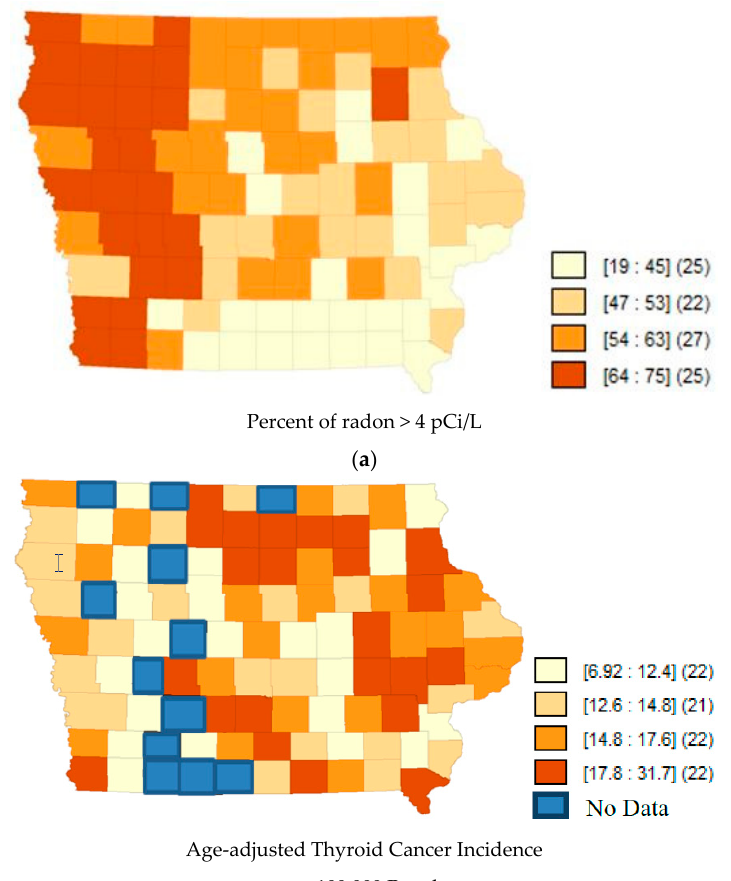
Figure 1. ( a ) Map of Quartiles of Radon Concentrations in Iowa counties. Darker shades represent a higher percent of radon above 4pCi/L. The numbers inside the brackets represent the range of percentages in that shade. The numbers inside the parentheses represent the number of counties in that quantile. Data accessed from AirChek, 2017. ( b ) Map of Quartiles of Age-adjusted Thyroid Cancer Incidence (1990–2013) in Iowa counties. Darker shades of orange represent higher rates of thyroid cancer incidence. The blue color represents the counties that lacked data from the public database. The numbers inside the brackets represent the range of incidence rates per 100,000 in that shade. The numbers inside the parentheses represent the number of counties in that quantile.